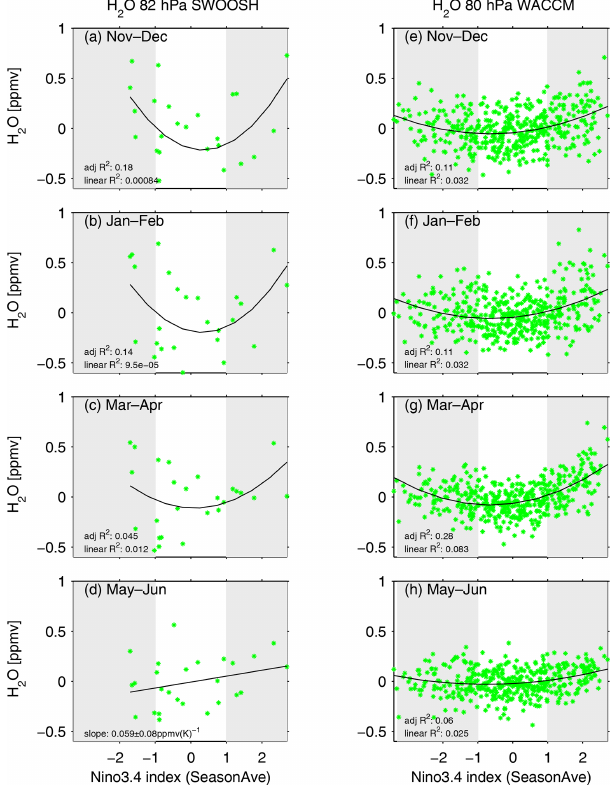
Figure 1. Anomalous 80hPa water vapor in WACCM compared with the value of the Nino3.4 index for (a) November and Decem- ber, (b) January and February, (c) March and April, and (d) May and June. Each dot corresponds to 1 model year. When a polynomial fit better describes the dependence on ENSO than a linear fit, we show the R 2 for a linear fit and the adjusted R 2 for the polynomial fit (see Sect. 2.2). Otherwise we show a linear least squares best fit in each